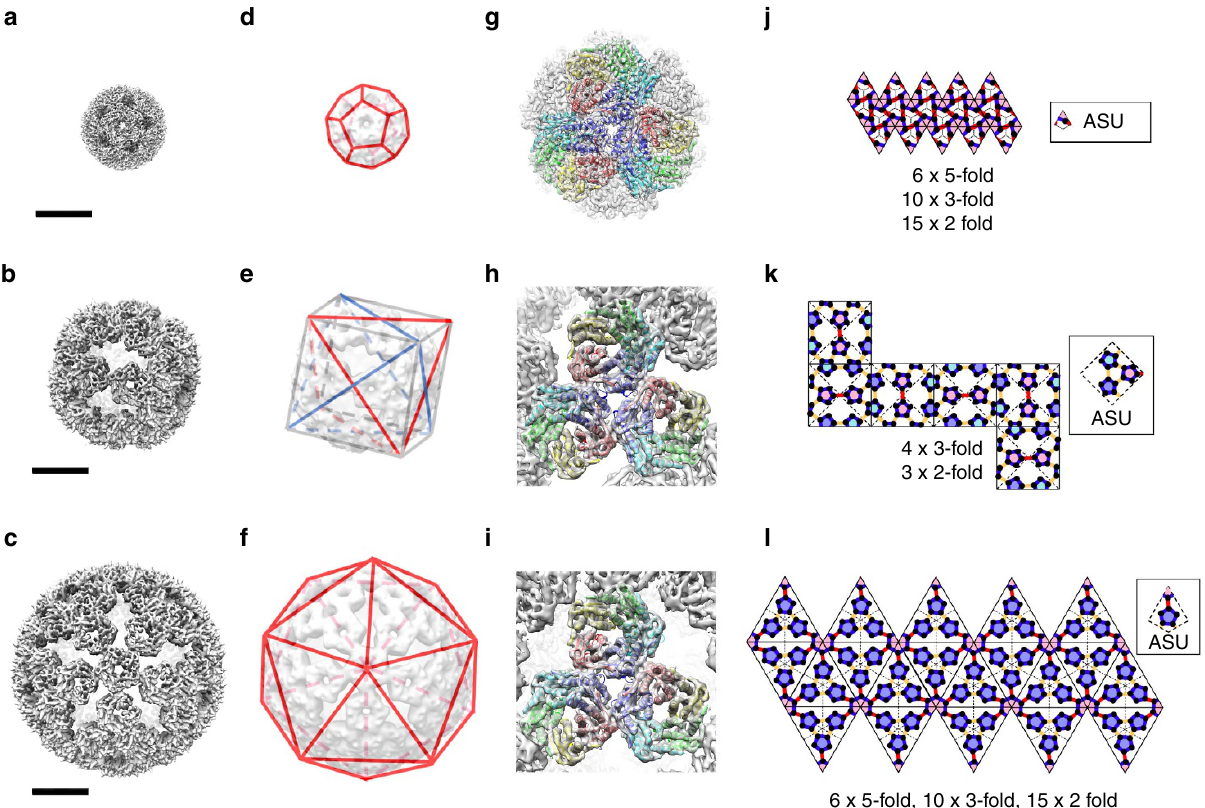
Figure 3 | Cryo-EM structures of the AaLS variants. ( a – c ) Cryo-EM density maps of AaLS-wt ( a ), AaLS-neg ( b ) and AaLS-13 ( c ) at 3.9, 5.4 and 5.2Å resolution, respectively. Scale bars: 10nm. ( d – f ) Dodecahedral, tetrahedral and icosahedral lattices matching the respective symmetries of AaLS-wt ( d ), AaLS-neg ( e ) and AaLS-13 ( f ). For AaLS-neg, two tetrahedral lattices (red and blue), embedded in a cube (grey), are depicted. ( g – i ) Close-up views of cryo-EM density maps of AaLS-wt ( g ), AaLS-neg ( h ) and AaLS-13 ( i ) around the three-fold rotational symmetry axes. Three pentamers from the refined models are shown as coloured ribbon diagrams. ( j – l ) 2D representation of the symmetry lattices for AaLS-wt ( j ), AaLS-neg ( k ) and AaLS-13 ( l ). Although the AaLS-neg structure is projected onto a flattened cube, note that it lacks the four-fold symmetry axes of a true cube because of the distinct pattern of pentamers on each face of the object and hence only possesses tetrahedral symmetry. The contact bars between two adjacent pentamers that have wt-like (pseudo) two-fold rotational symmetry are shown in red, while the other contact bars are shown in yellow. The asymmetric unit (ASU) for each structure is shown in the